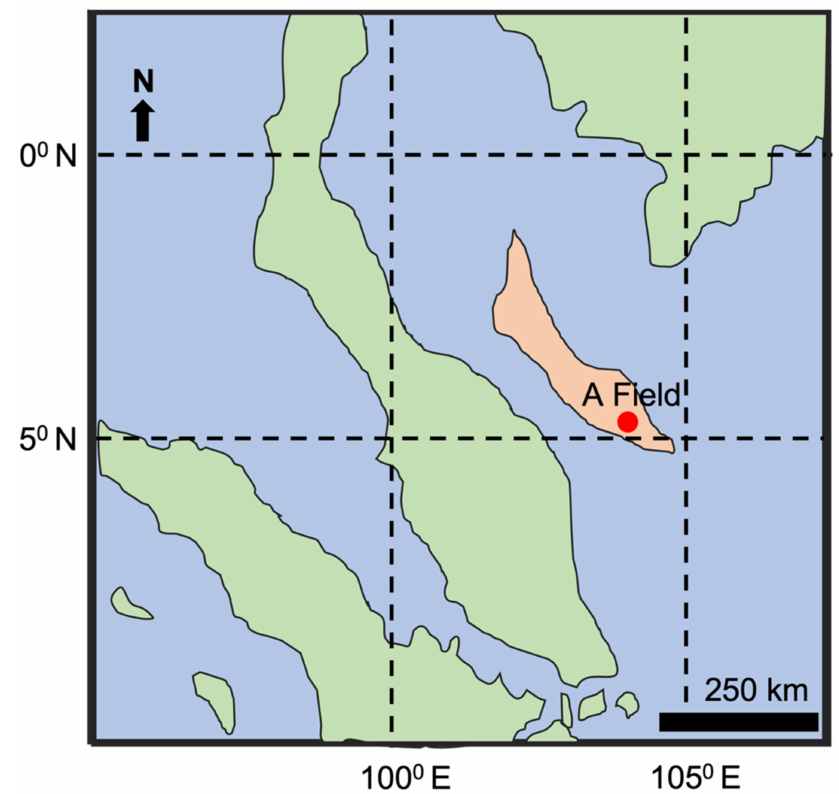
Figure 3. The location of A